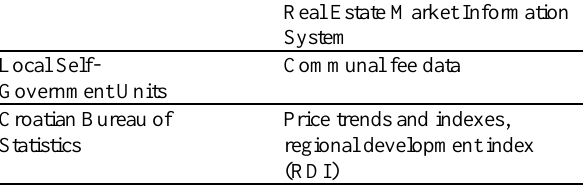
Table 1 . Land and other registers data sources